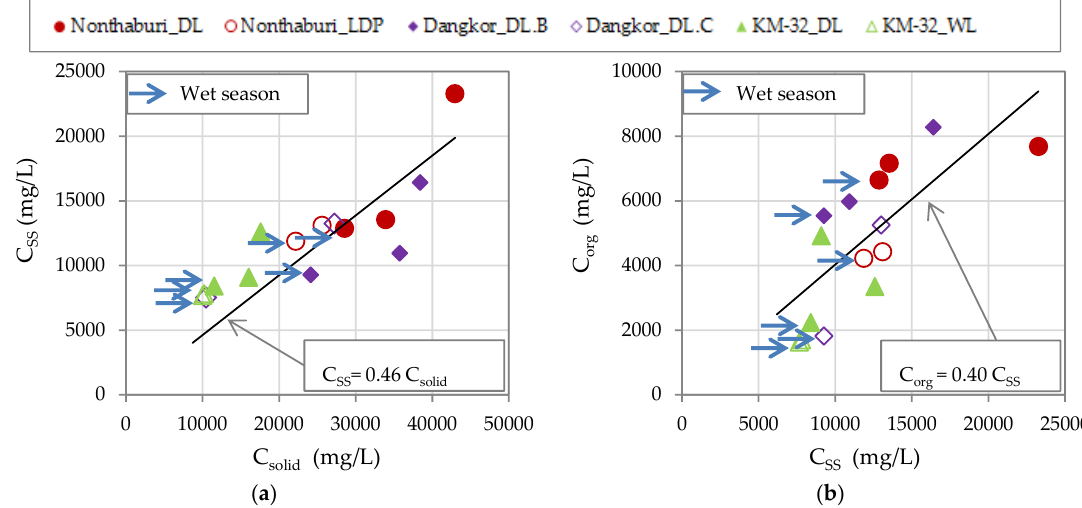
Figure 6. ( a ) Relationship of SS concentration (C SS ) and total solid concentration (C solid ) of the leachate; ( b ) Relationship of organic content (C org ) and SS concentration (C SS ).